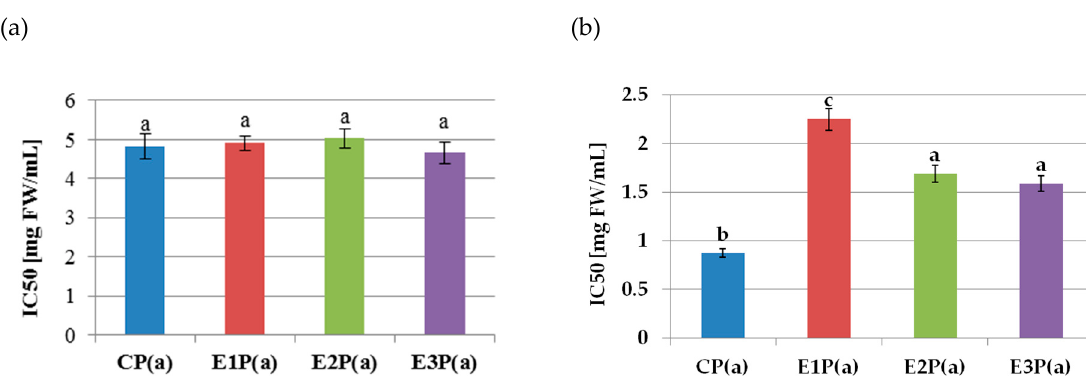
Figure 2. Inhibition of the activity of ( a ) lipoxygenase, ( b ) cyclooxygenase-2, by purified anthocyanin fractions from pomace obtained from raspberries subjected to enzymatic maceration. Mean values marked with the same letters do not differ significantly in terms of p ≤ 0.05. Symbols: CP(a)—purified anthocyanin fraction from pomace obtained from control raspberry pulp; E1P(a)—purified anthocyanin fraction from pomace obtained from raspberry pulp macerated with Pectinex Ultra SP-L; E2P(a)—purified anthocyanin fraction from pomace obtained from raspberry pulp macerated with Pectinex Yield-Mash; E3P(a)—purified anthocyanin fraction from pomace obtained from raspberry pulp macerated with Ultrazym AFP-L